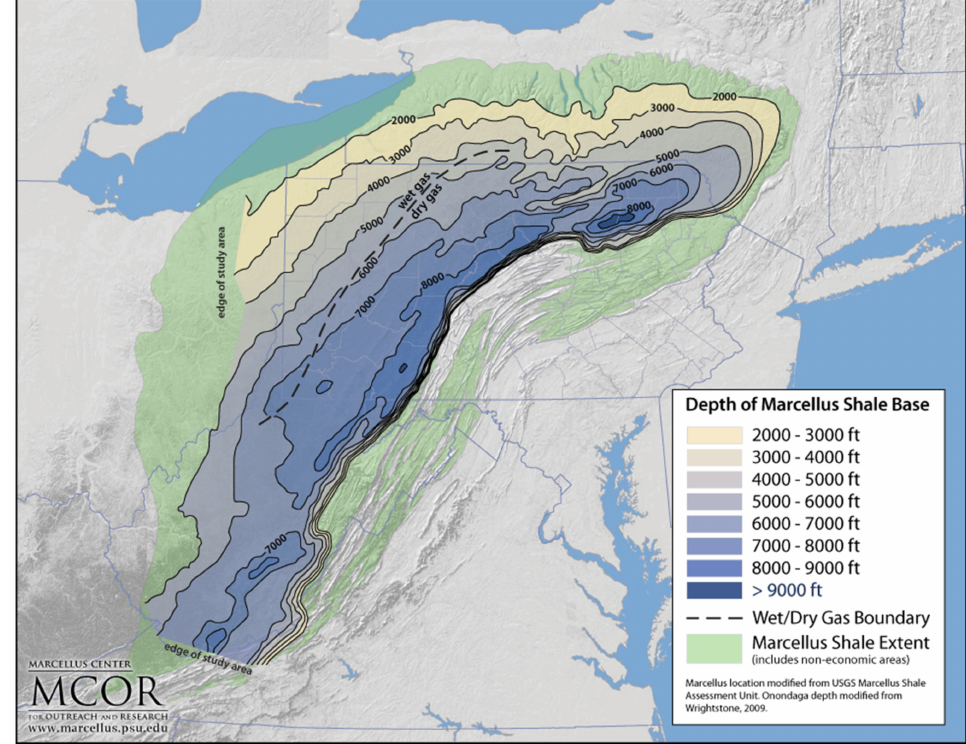
Figure 1. Map showing regional distribution of wet gas and dry gas produced from the Marcel- lus Formation in the Appalachian basin. Contours are depth in feet to the base of the Marcellus. Downloaded from the Pennsylvania State University Marcellus Center for Outreach and Research, http://www.marcellus.psu.edu/resources/images/wet-dry--line--with--depth.gif. (Accessed on 6 April